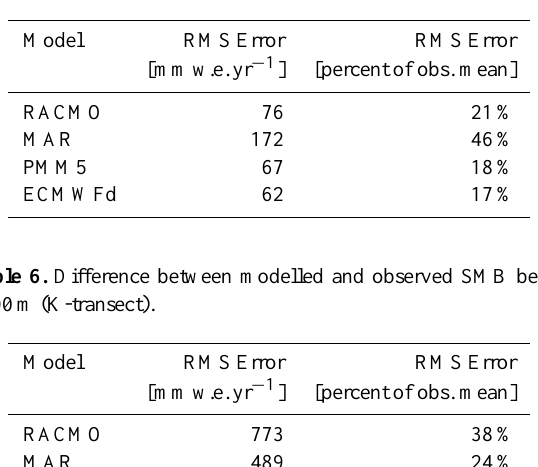
Table 5. Difference between modelled and observed SMB above 1500m.